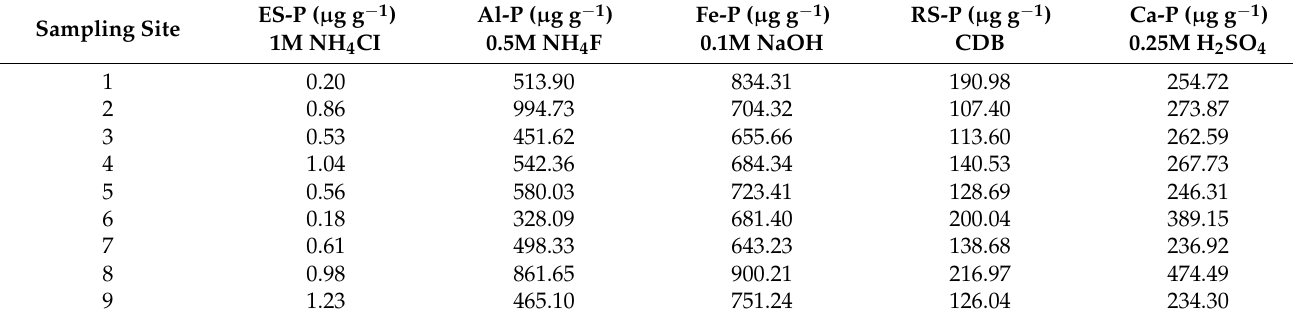
Table 4. Data of content of different P fractions ( µ g g − 1 ) of sediments in the Terragido reservoir. Sampling